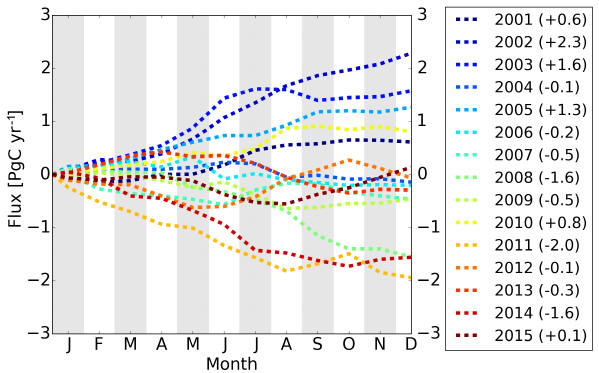
Figure 4. Monthly development of the cumulative annual anomalies in the global natural carbon fluxes (biosphere and ocean net sinks and biomass burning emissions). Anomalies are calculated from the mean over 2001–2015 for each year, thereby removing the average seasonal cycle. Negative numbers indicate years with larger than av- erage net uptake and positive numbers represent years with smaller than average net